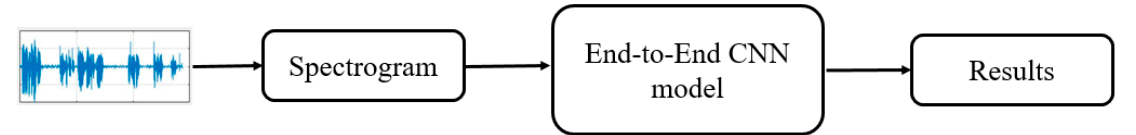
Figure 1. Typical flow of speech emotion recognition system, which is show the flow from raw data to classification results.